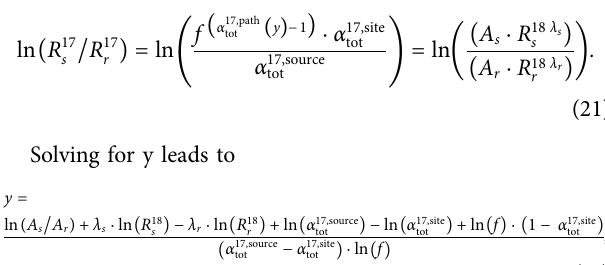
Frontiers in Earth Science |